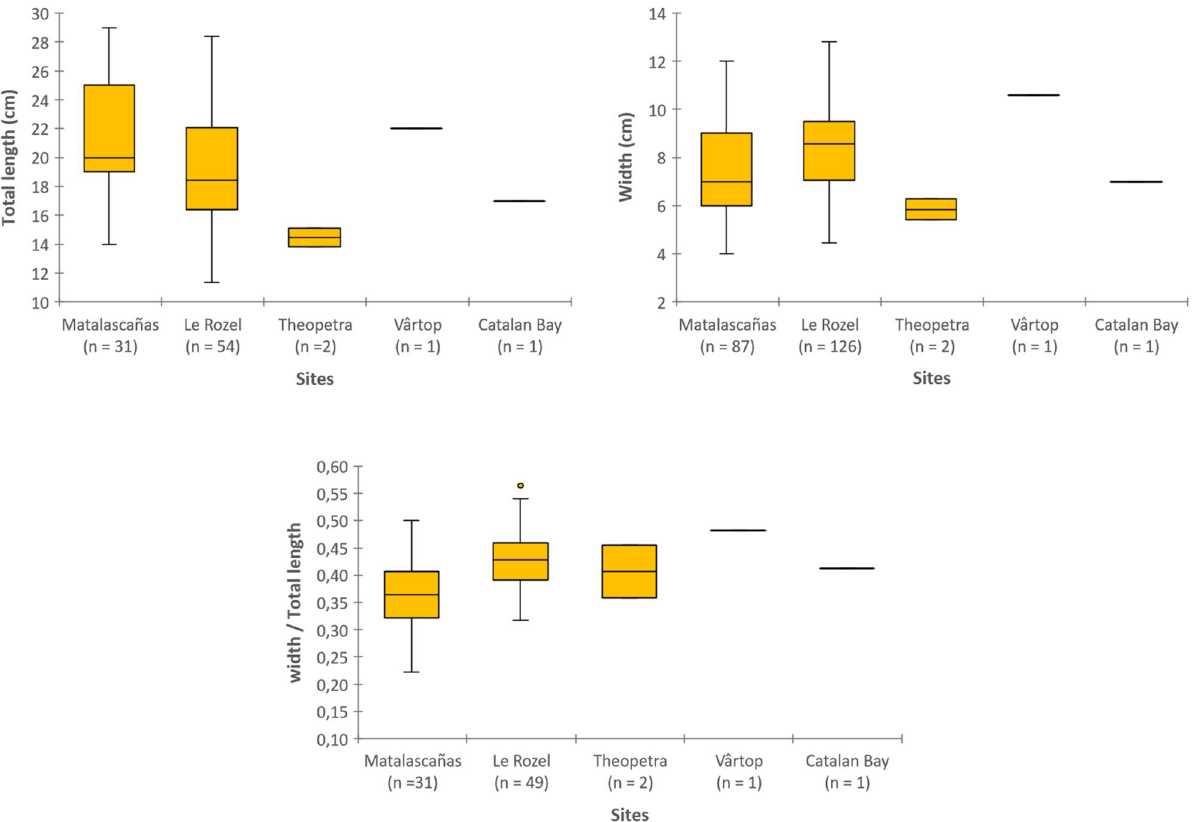
Figure 5. Comparisons of dimensions (total length and width) and proportions (width/total length) between the Matalascañas footprints and the other footprints attributed to Neandertals: the footprints from Le Rozel 5 , two of the Theopetra footprints 23 , the complete Vârtop footprint 24 , and the Catalan Bay footprint 13